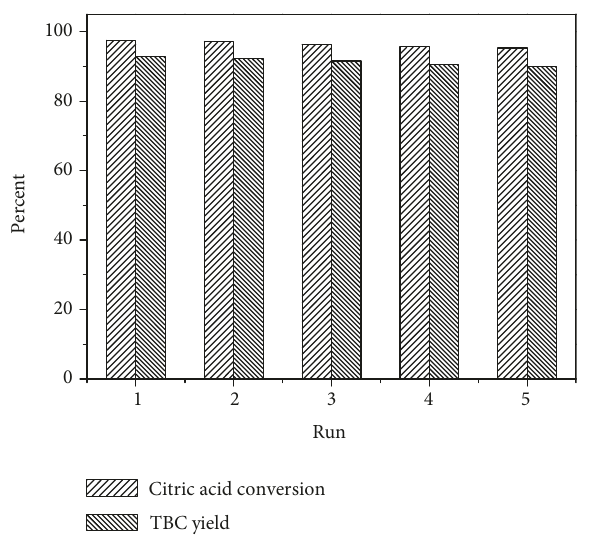
Figure 6: Reusability of the [BsPVPP]HSO esteri fi cation of citric acid with n-butanol. Reaction conditions: citric acid, 0.06mol; n-butanol, 0.31 mol; catalyst, 6.6wt%; temperature, 120 ° C; time,